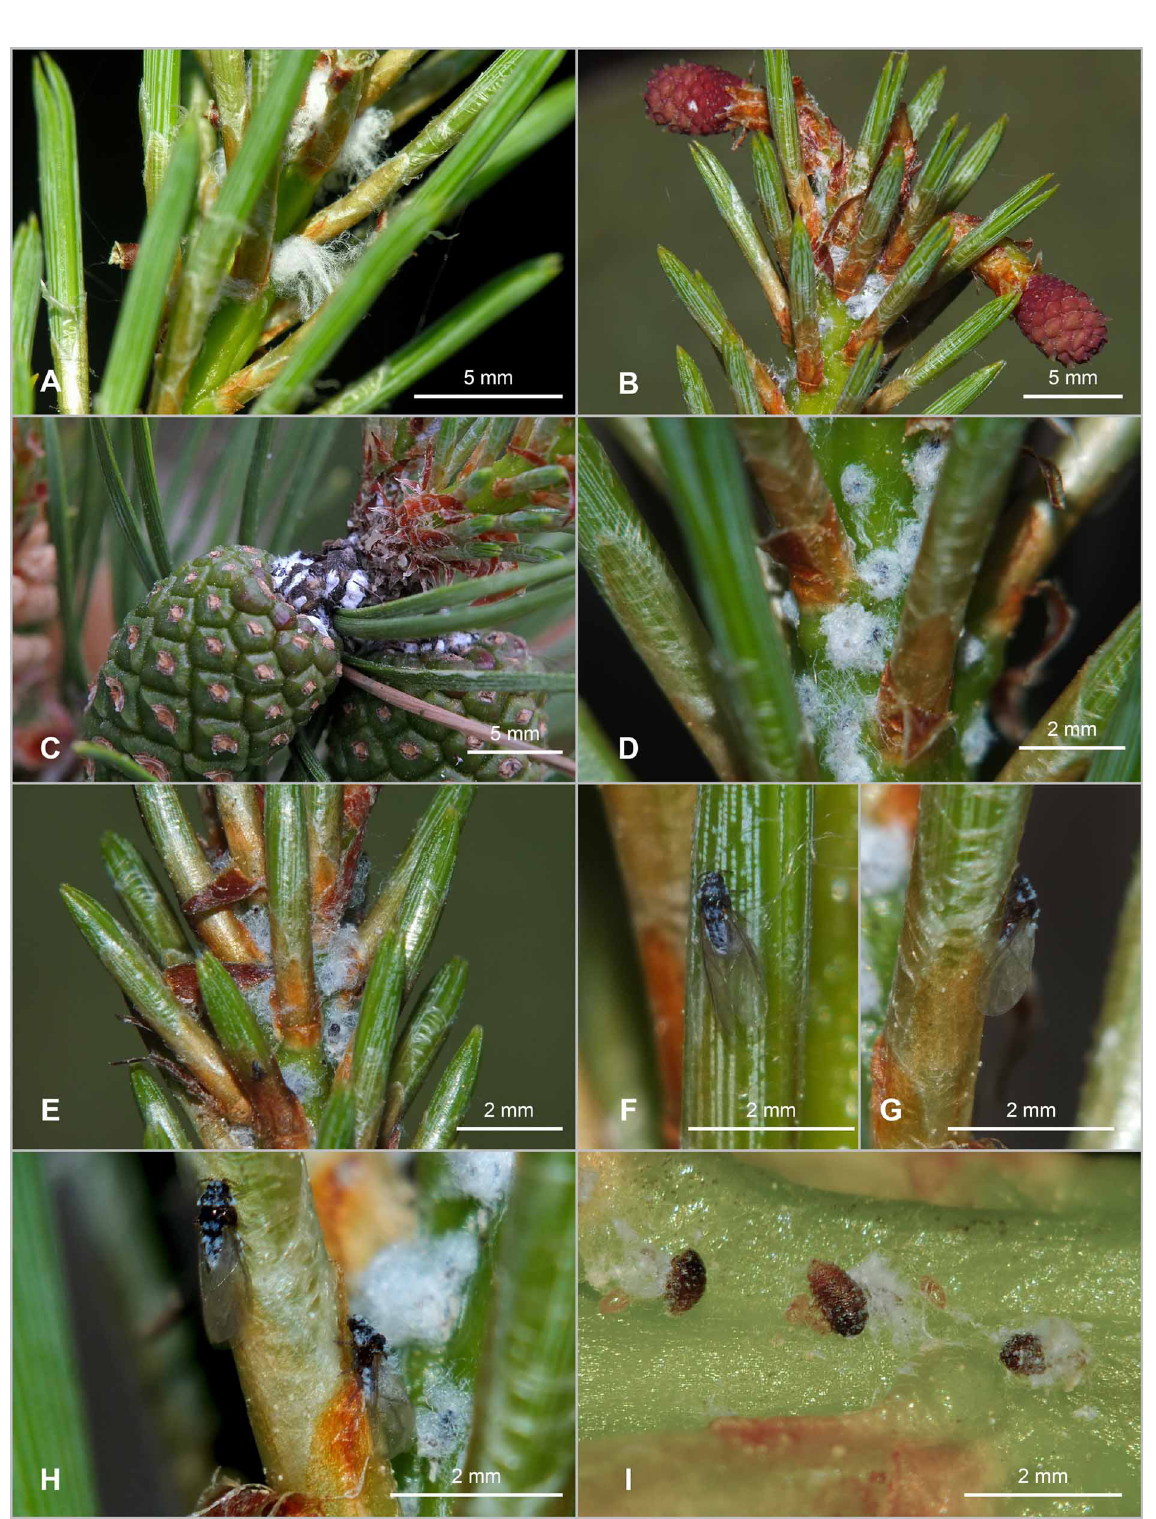
Fig. 73. Pineus (Pineus) pini (Macquart, 1819) on young growth of Pinus sylvestris . A . Apterae. B–D . Apterae and juvenile alatae. E–H . Alatae. I . Apterae with wax wool